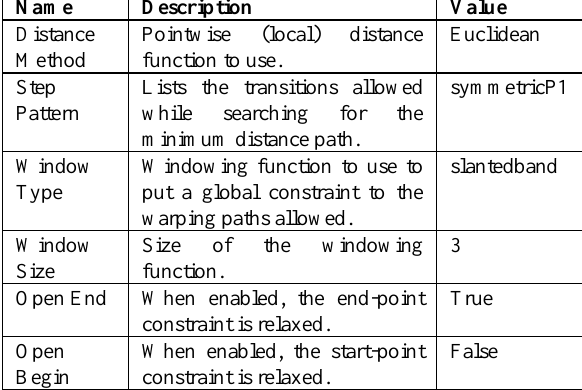
Figure 2. Vector data of verified sugarcane plantations showing the location of Site A, B, and C.